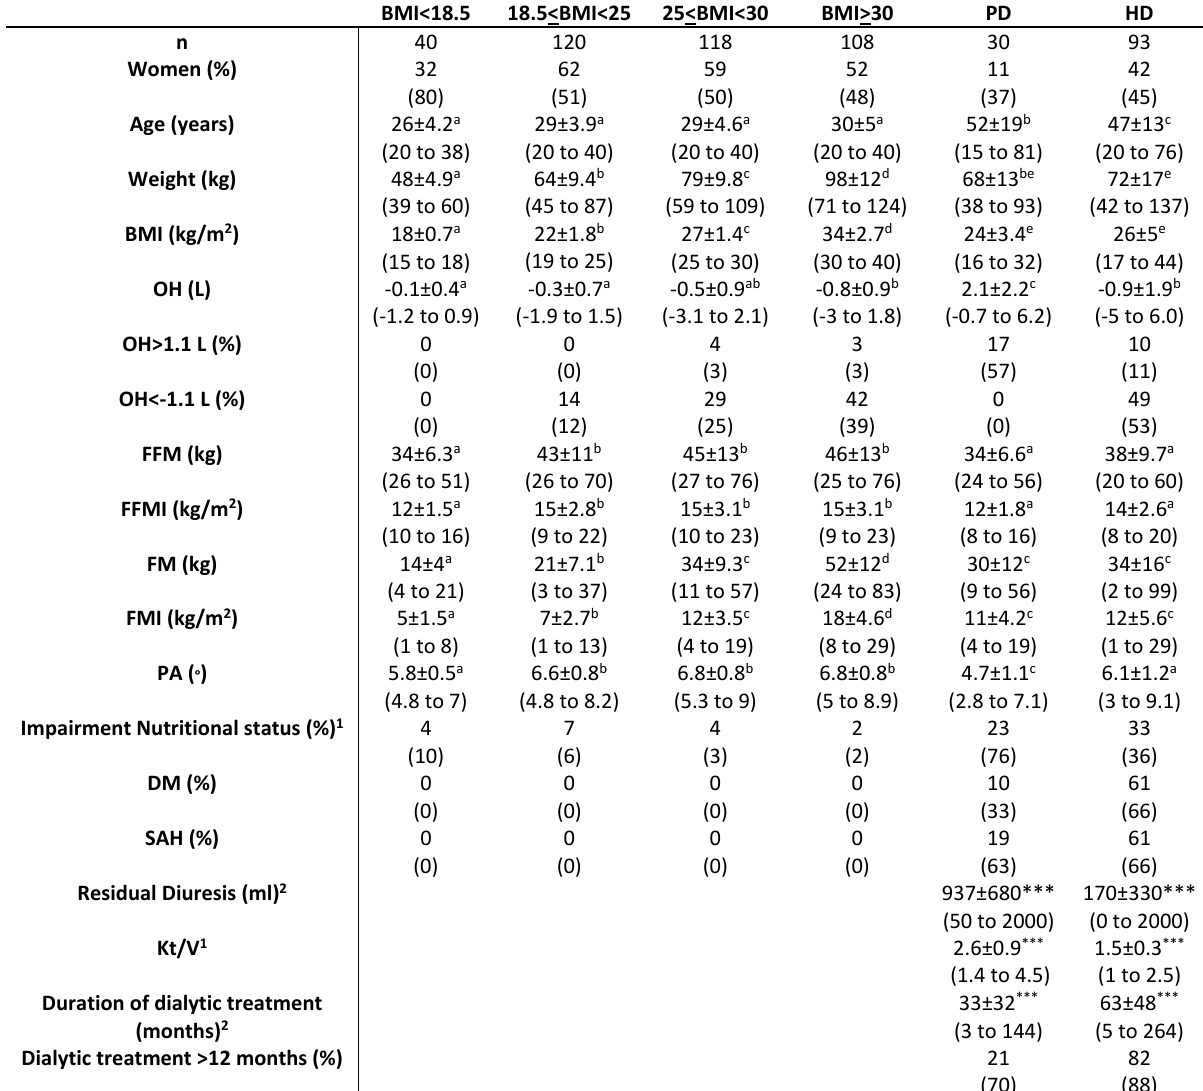
Table 1. Descriptive data for non-CKD subjects stratified in BMI subgroups and for CKD patients stratified in PD and HD